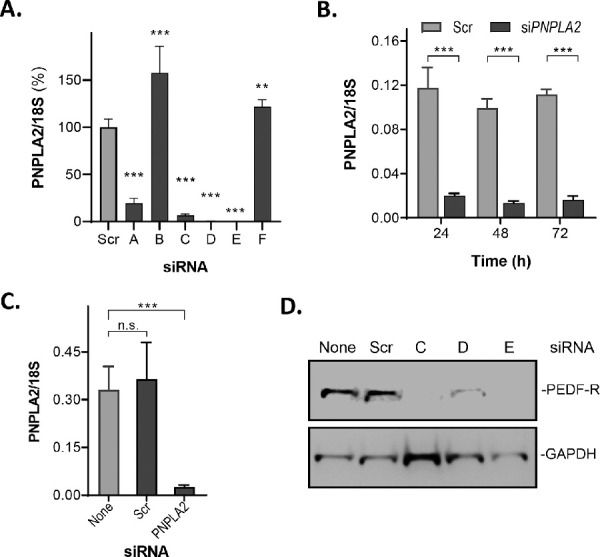
Knockdown of PNPLA2 in ARPE-19 cells. ARPE-19 cells were transfected with Scr or siRNAs targeting PNPLA2, and mRNA levels and protein were tested. (A) RT-qPCR to measure PNPLA2 mRNA levels in ARPE-19 cells 72 hours after transfection with Scr and six different siRNAs (as indicated on the x-axis) was performed, and a plot is shown. PNPLA2 mRNA levels were normalized to 18S. All siRNA are represented as the percentage of the scrambled siRNA control (n = 3). (B) A plot is shown for a time course of PNPLA2 mRNA levels following transfection with Scr and siPNPLA2-C (n = 3 (C) RT-qPCR of mock-transfected cells, cells transfected with Scr, and siPNPLA2-C (x-axis) at 72 hours after transfection. mRNA levels were normalized to the 18S RNA (y-axis) (n = 3). (D) Total protein was obtained from cells harvested 72 hours after transfection and resolved by SDS-PAGE followed by western blotting with anti-PNPLA2 and anti-GAPDH (loading control). The siRNAs used in the transfections are indicated at the top, and migration positions for PEDF-R and GAPDH are to the right of the blot. Data are presented as mean ± SD. **P < 0.01, ***P < 0.001, ***P < 0.001.